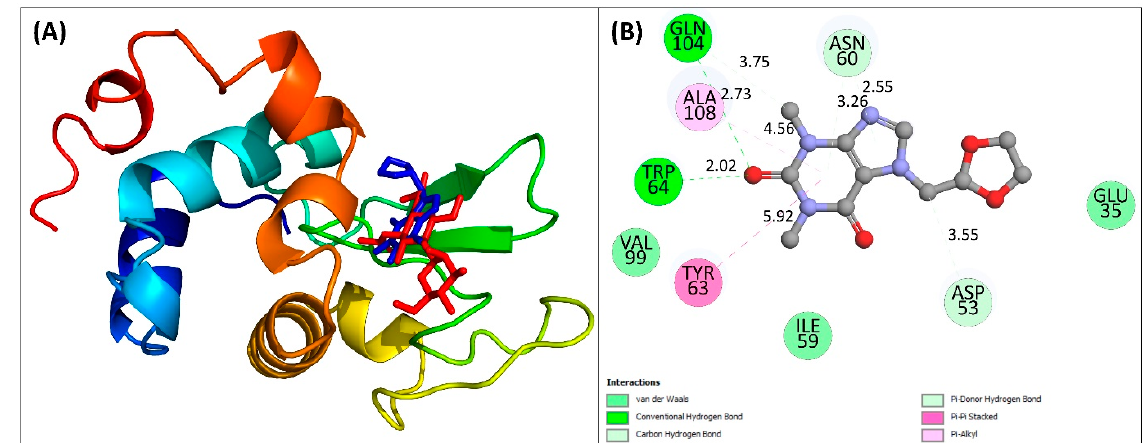
Figure 5. ( A ) Overlap of the docked structure of doxofylline with the original lysozyme–substrate complex. The doxofylline occupied same biding site as that of the substrate of lysozyme. Lysozyme is shown in ribbon model, doxofylline is shown as blue sticks, and substrate is shown as red sticks. ( B ) Two-dimensional view of the interaction of doxofylline with lysozyme.